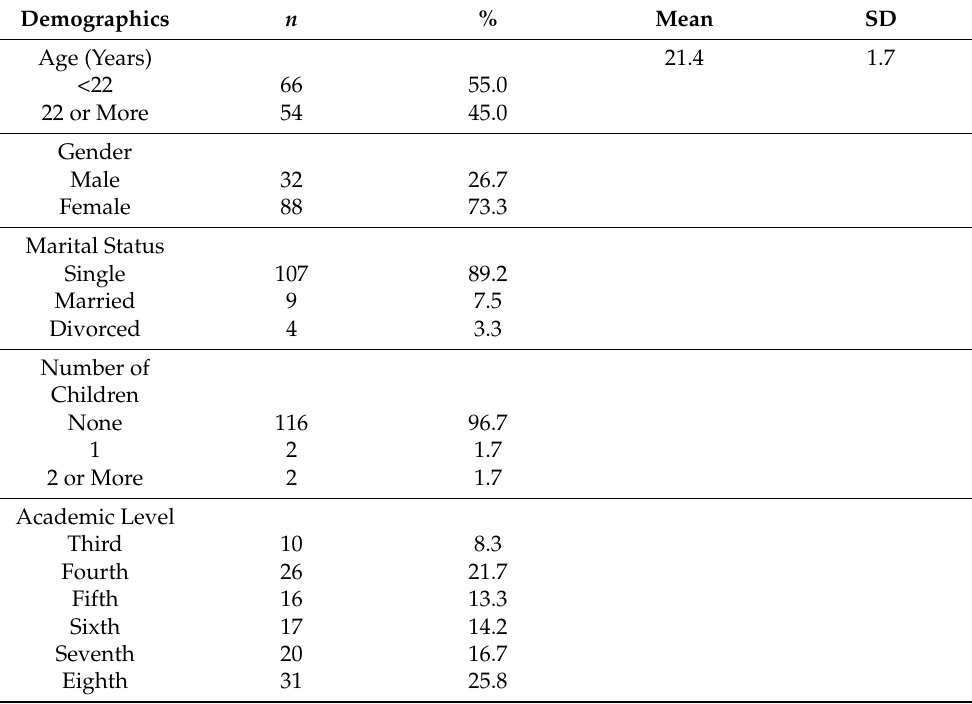
Table 1. Number and distribution of the sociodemographic characteristics of the